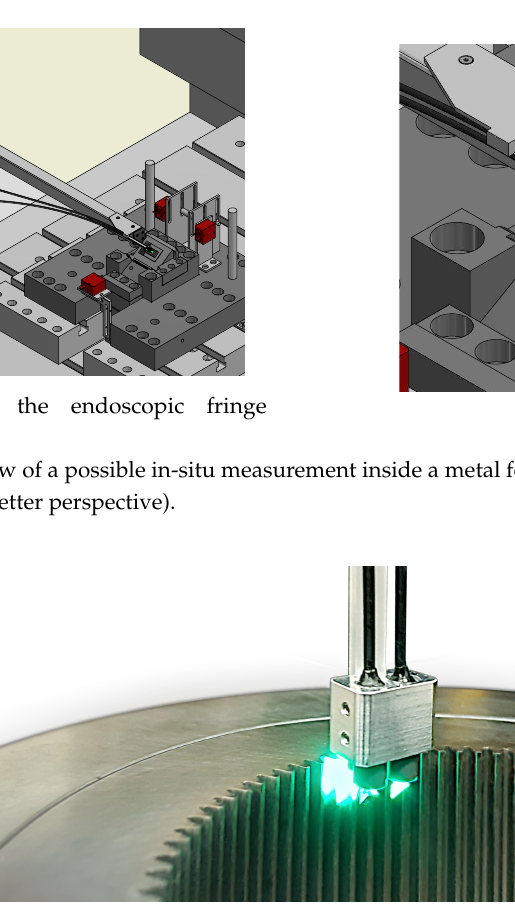
Figure 2. Specimen and measuring head while projecting structured